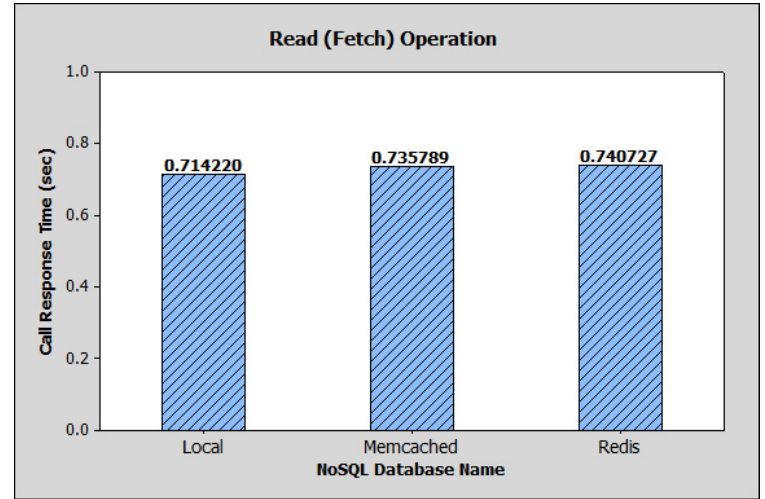
Figure 6. Call Response Time with read operation (Single Client).